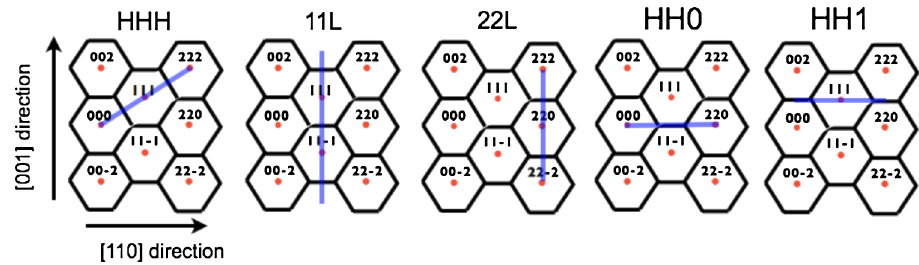
FIG. 2. Representations of the HHL scattering plane, showing the FCC Brillouin-zone boundaries and the corresponding zone centers (labeled in terms of the conventional simple-cubic unit cell). Blue lines indicate the directions of the five different cuts shown in Fig.